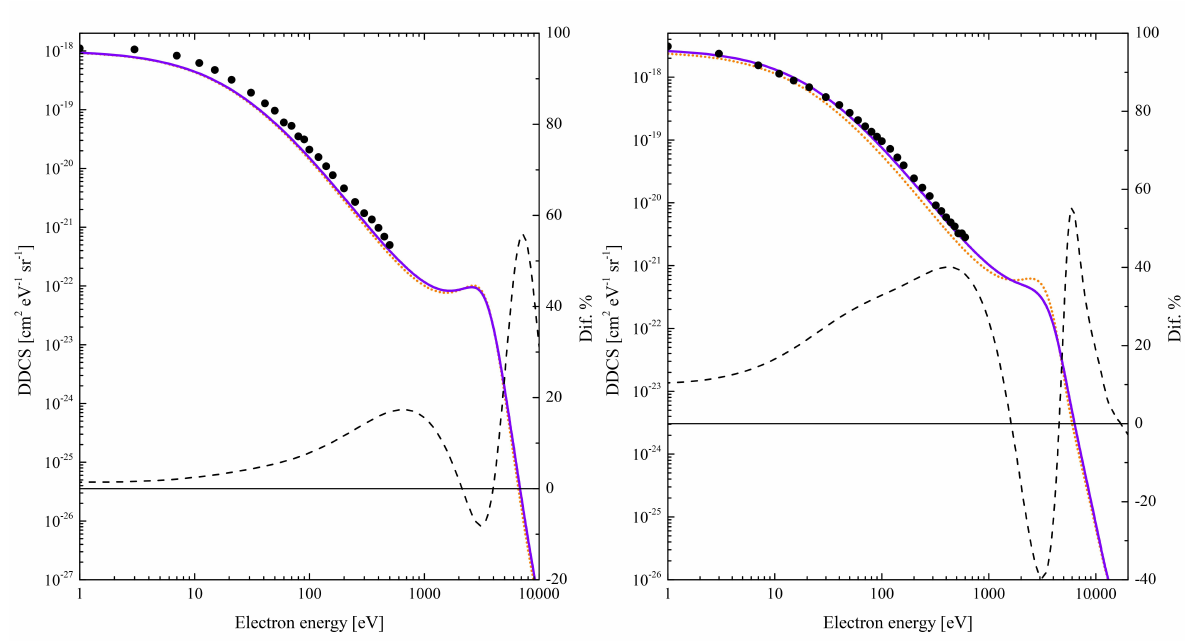
Figure 5. Ionization DDCS of He (left panel) and Ne (right panel) by 6 MeV/u C 6 + impact for a fixed 60 ◦ emission angle as shown in Figures 3 and 4. Dashed lines show the percentage of the relative difference (right axis) between post and complete hybrid post CDW calculations.